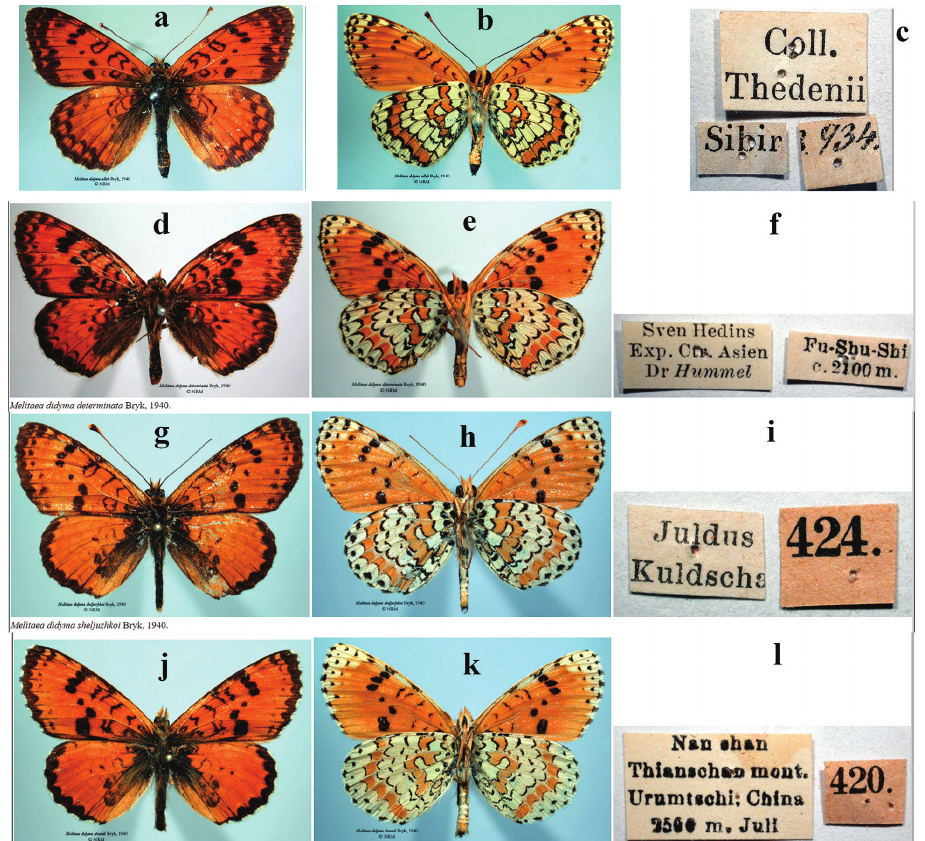
Figure 5. Syntypes of the taxa of the Melitaea ala species complex, originally described by Felix Bryk (1940) as subspecies of M. didyma . All specimens are deposited in Swedish Museum of Natural History (Naturhistoriska riksmuseet, NRM) a M. didyma allah , upperside b M. didyma allah , underside c M. didy- ma allah , labels d M. didyma determinata , upperside e M. didyma determinata , underside f M. didyma determinata , labels g M. didyma sheljuzhkoi , upperside h M. didyma sheljuzhkoi , underside i M. didyma sheljuzhkoi , labels j M. didyma strandi , upperside k M. didyma strandi , underside l M. didyma strandi ,